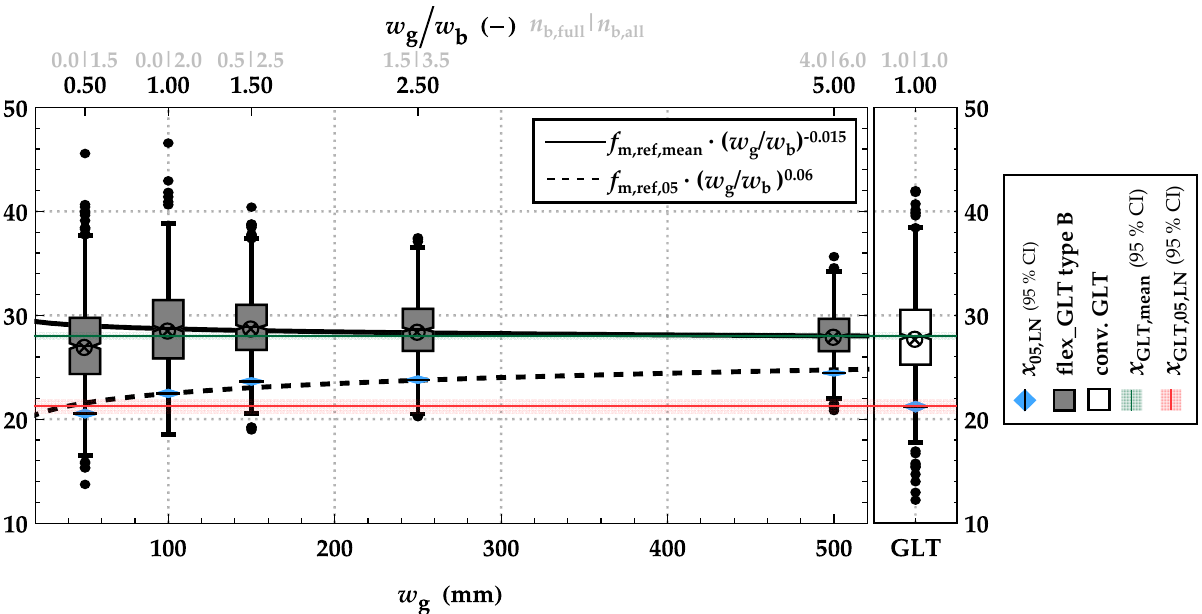
Figure 28. Boxplots together with mean and 5%-quantile values of the bending strength f m,g of flex_GLT type B beams featuring a depth of h g = 360 mm and different beam widths w g = {50; 100; 150; 250; 500} mm and conventional glulam (reference) of similar depth and width w g = 100 mm built up from boards of group GI (T14) with dimensions of w b = 100 mm and t b = 30 mm. Figure 29. Average numbers of boards acting in parallel in the bending–tension zone of flex_GLT type B beams in dependence on the width ratio w g / w b : total number of boards ( n b,all ); number of boards in full cross-section ( n b,full ); number of lengthwise split boards ( n b,split ). Following the outcomes, flex_GLT type B beams featuring the same ratio as conven- tional glulam ( w g / w b = 1.00) have approximately a 6% higher characteristic (5%-quantile) bending strength than conventional glulam. Although flex_GLT beams of this kind com-